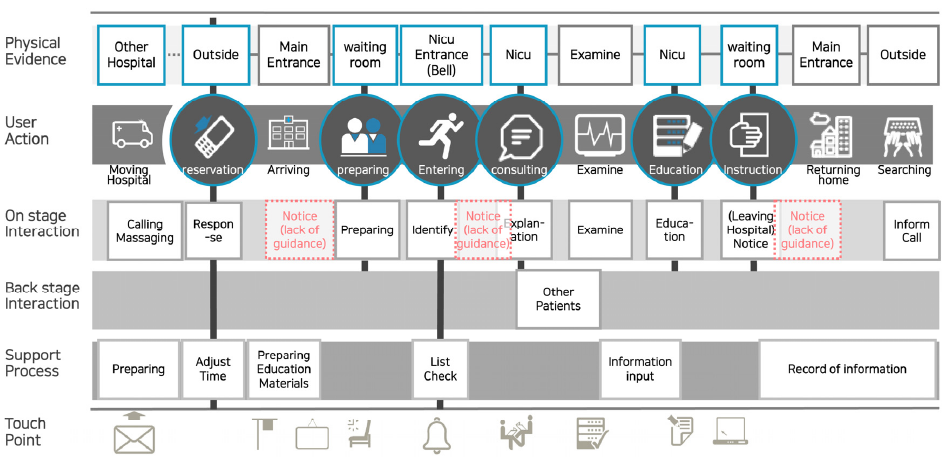
Figure 3. Service blueprint: A layout of services demonstrating the flow of experience from the parents’ perspective that outlines interactions with various stakeholders who provide the